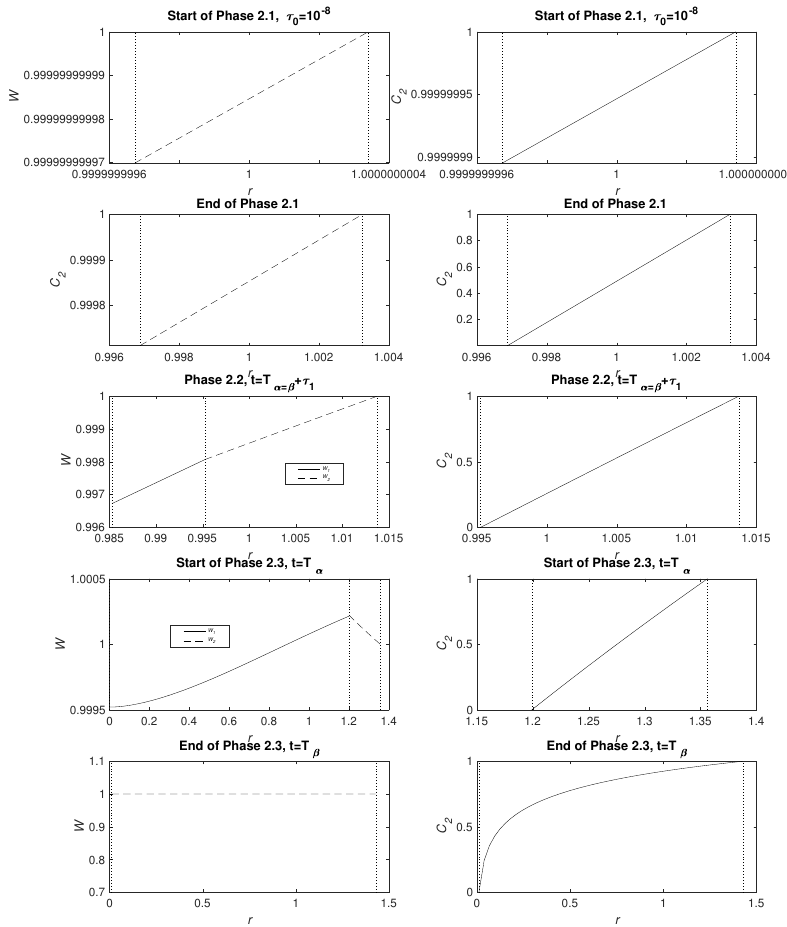
Figure 3. Plots of the dimensionsionless variables concentrations W 1 , W 2 (left) and C 2 (right) at, from top to bottom, the start of Phases 2.1 ( t = τ 0 = 10 − 8 ), end of Phase 2.1 ( t = T α = β ≈ 0.095), Phase 2.2 ( t = T α = β + τ 1 , with τ 1 = 0.356, see Appendix B.3), start of Phases 2.3 ( t = T α ≈ 33.1) and the end of 2.3 ( t = T β ≈ 1291) in cylindrical geometry. In the left-hand panel, the solid lines are W 1 and the dashed lines W 2 . The vertical dotted lines indicate from right to left, r = S , r = β (top 3 plots) and r = β (top 2 plots). The parameters are ε 1 = 0.6, ε 2 = 0.4, κ ≈ 0.04, S 0 = 1 and the rest listed in Table